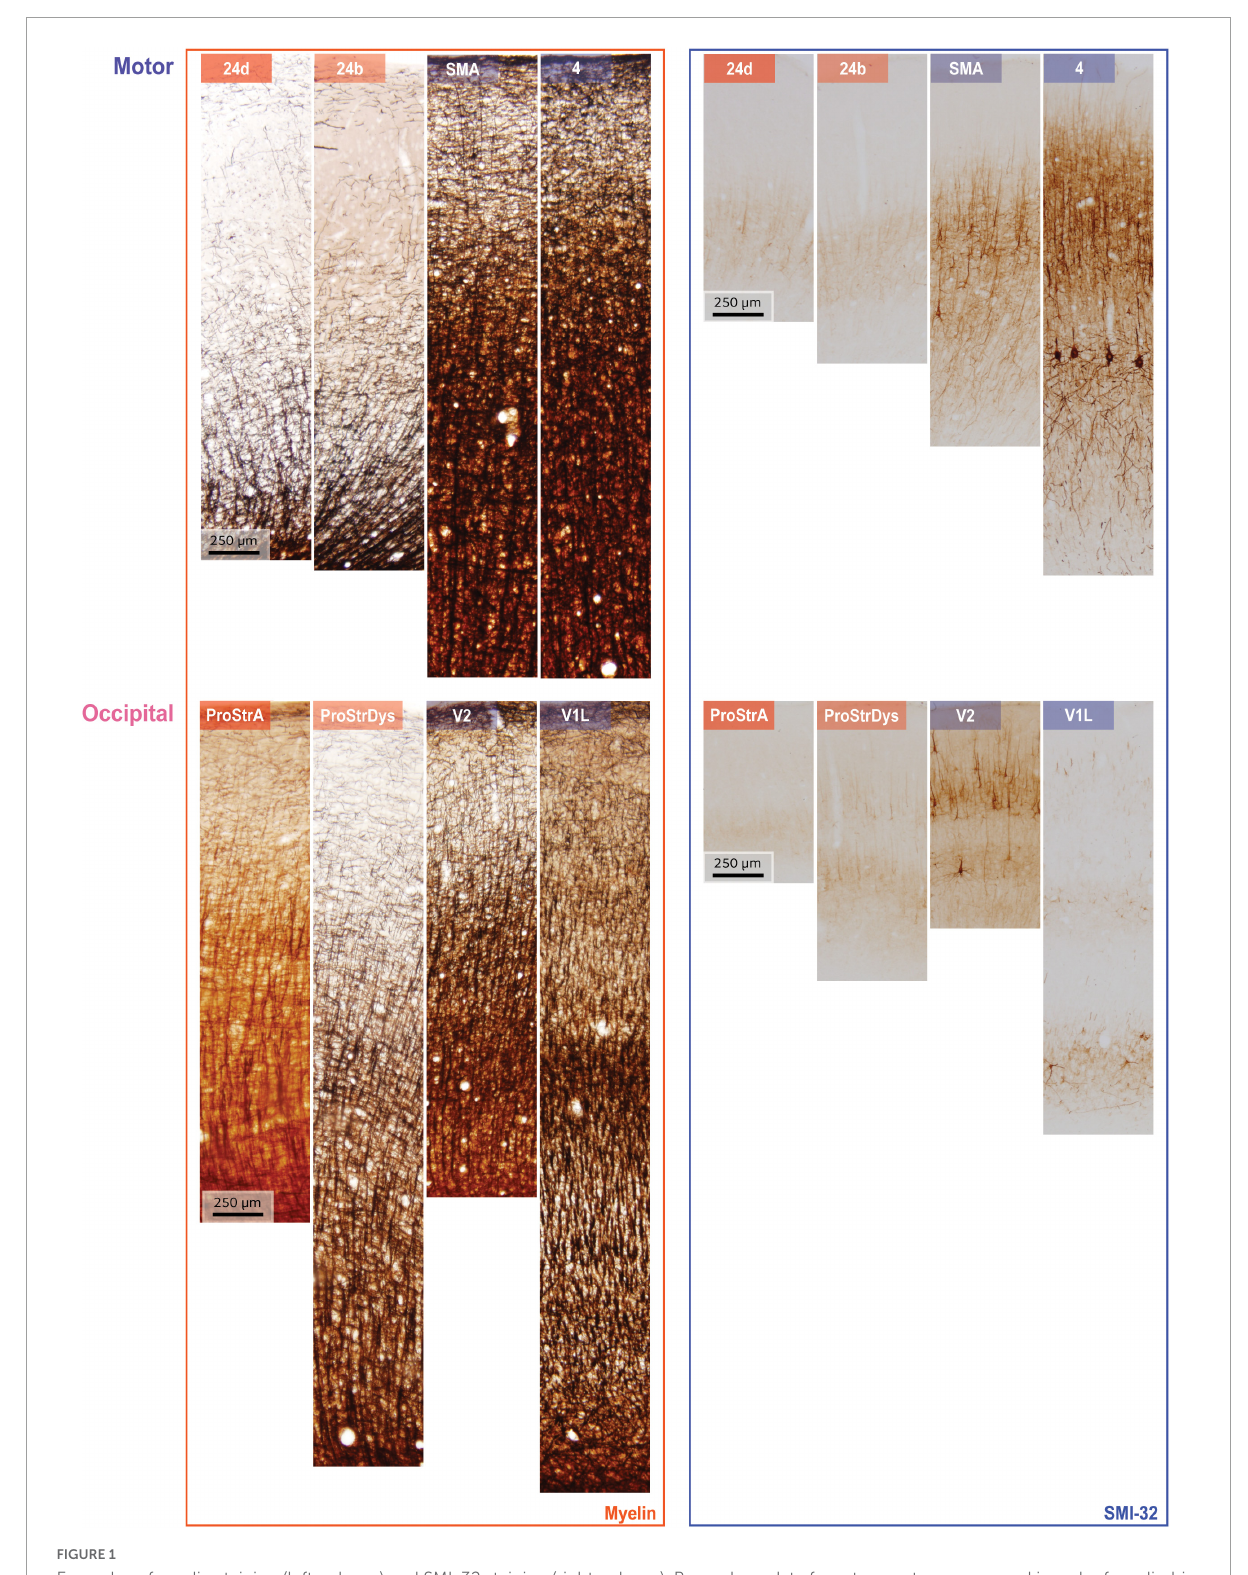
FIGURE1 Examples of myelin staining (left column) and SMI-32 staining (right column). Rows show data from two systems, arranged in order from limbic (left) to eulaminate (right). Top: areas along the motor cortical axis, bottom: areas along the occipital cortical axis. Variations in cortical thickness from pia to white matter, for both myelin and SMI-32, arise due to non-uniform shrinkage during tissue